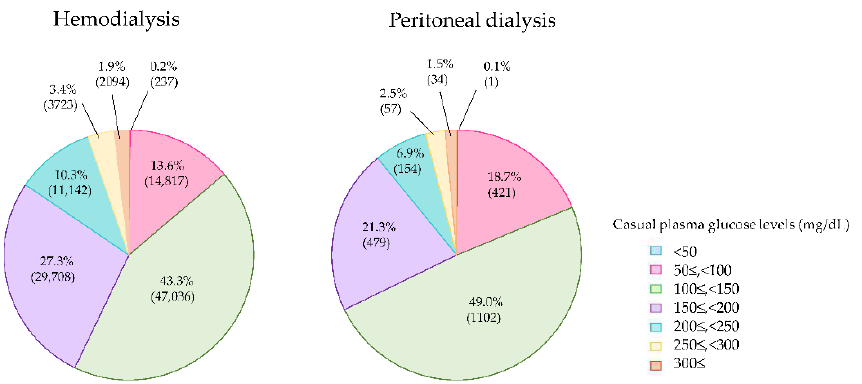
Figure 2. Casual plasma glucose levels of diabetes patients on hemodialysis and peritoneal dialysis in 2018.